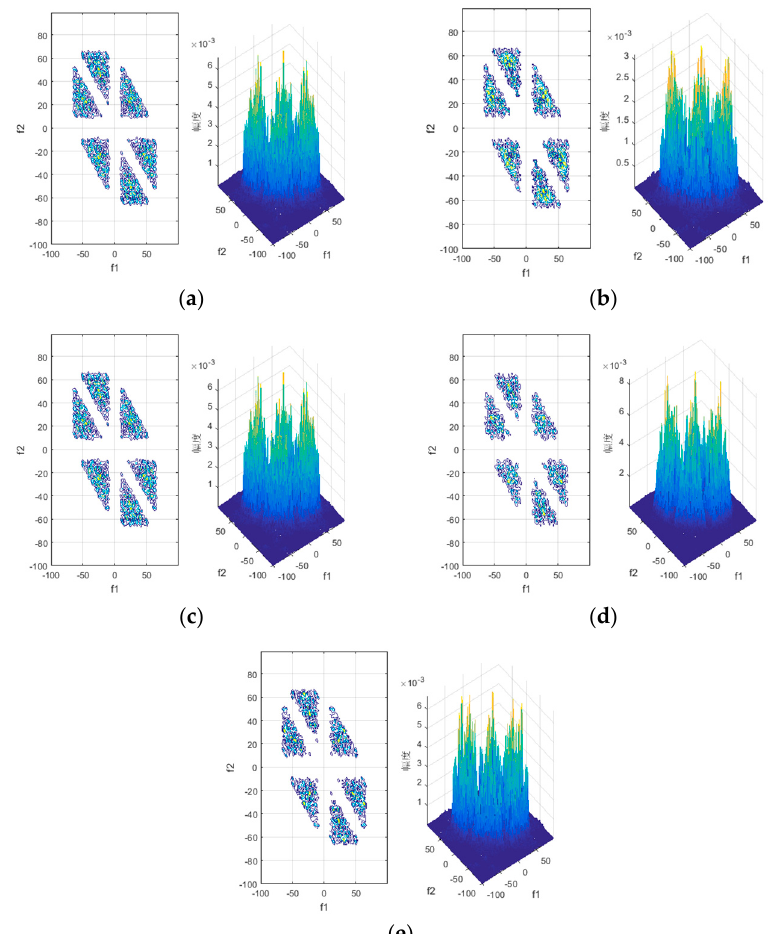
Figure 8. Bispectrum estimations of the five kinds of communication behaviors: ( a ) automatic link establishment behavior; ( b ) traffic management and HDL acknowledgement behavior; ( c ) HDL traffic data behavior; ( d ) LDL traffic data behavior; ( e ) HDL acknowledgement behavior. HDL: high ‐ rate data link protocol; LDL: low ‐ rate data link protocol.